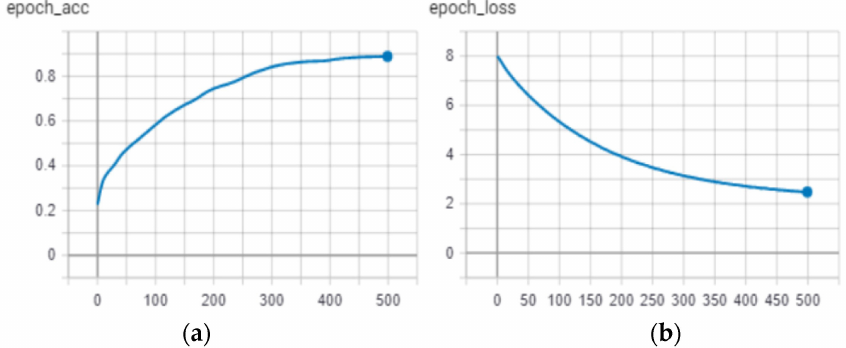
Figure 11. Accuracy ( a ) and loss ( b ) for the proposed model with the Adagrad optimizer for a 500 epoch